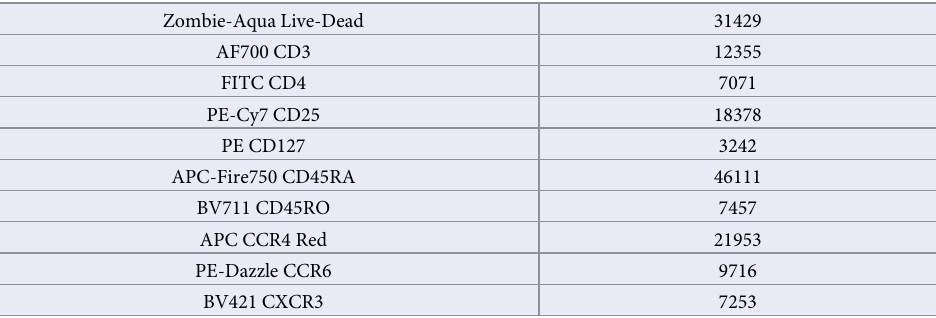
Table 2. MFI values for each detector channel.